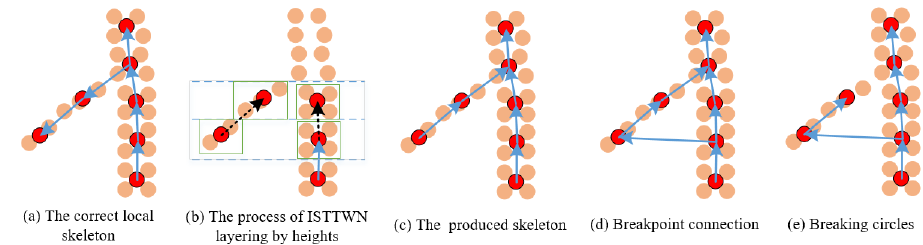
Figure 4. The problem in the skeleton produced by ISTTWN algorithm layering by heights.